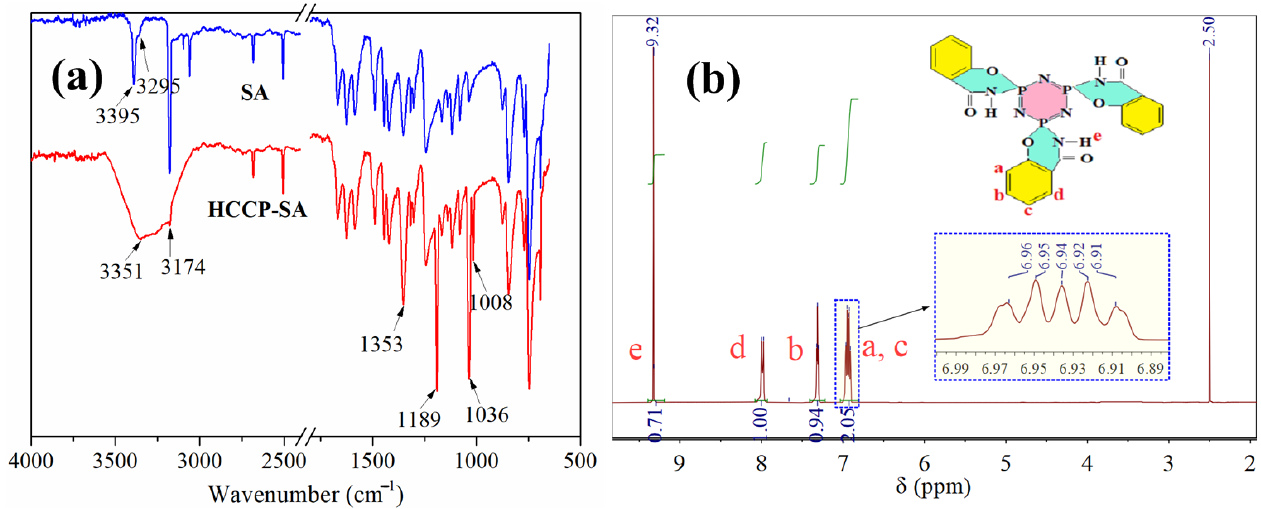
Figure 2. FTIR ( a ) and 1 H NMR ( b ) of SA and HCCP-SA. In ( b ), a, b, c, d and e represents the peak of H atom at a, b, c, d and e in the molecular formula of HCCP-SA, respectively. An 1 H NMR analysis was executed to further analyze the structure of the HCCP-SA, and the NMR spectrums are presented in Figure 2b. It can easily be observed in Figure 2b that the chemical shift at 2.50 ppm was apportioned to DMSO-d6, which is used as a sol- vent for HCCP-SA. The multiple absorption peaks centered at 6.94 ppm (m, 2H) can be attributed to the coupling of H atoms corresponding to H a and H c in the benzene ring structure. The peaks centered at 7.31 (t, J = 6.6, 1H) and 7.98 ppm (d, J = 2.8, 1H) can be 160 attributed to H b and H d in the benzene ring structure, respectively. A single strong peak 161 at 9.32 ppm (s, 1H) was assigned to H e atoms, which was the only secondary amino hy-